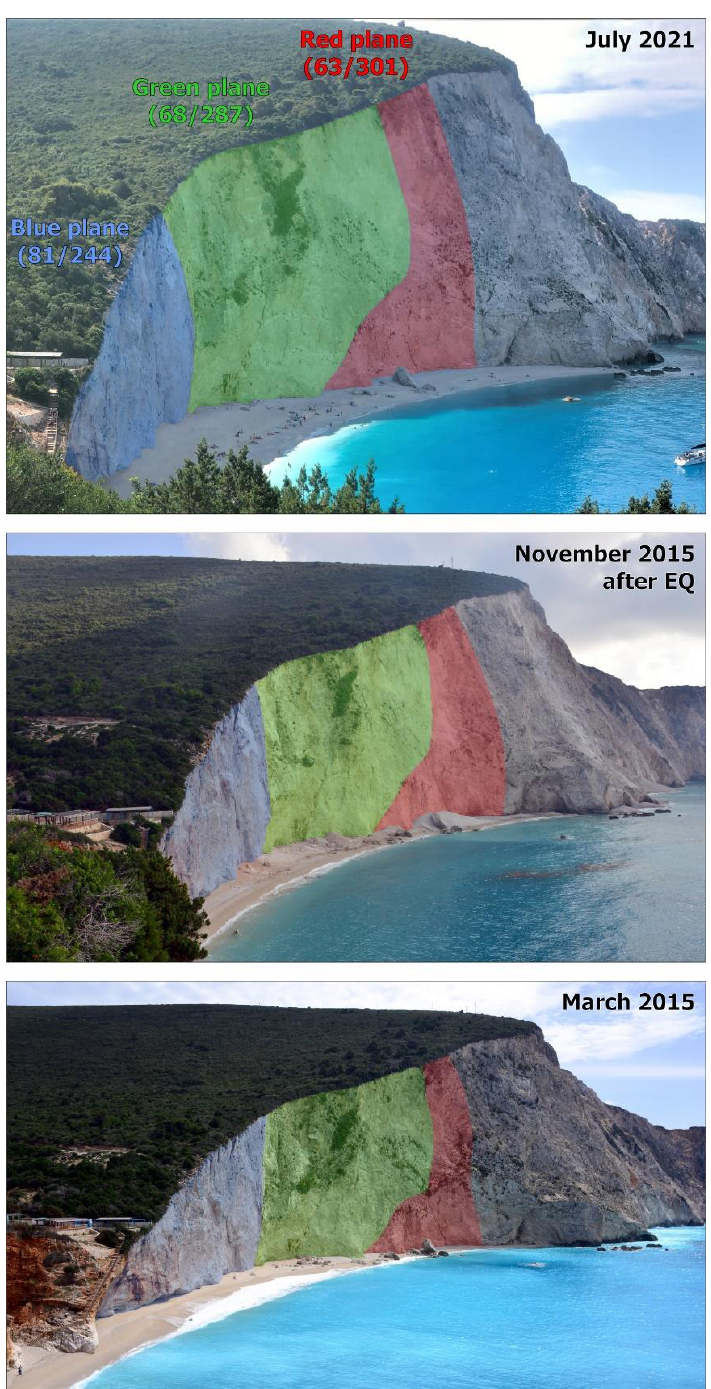
Figure 10. The three morphological planes detected from the TLS survey in the Porto Katsiki coastal area. The blue plane corresponds to the northern segment, the green to the middle and the red to the southern. The discontinuities detected along the planes’ intersection create conditions favorable to failure. Taking into account the presence of boulders and other smaller fragments along the beach, it is concluded that the southern segment of the slope (red plane) is characterized by the highest susceptibility to large rockfalls with impact on the adjacent beach. Please note the colors used correspond to the three generic morphological planes detected through the TLS application and are shown in Figure